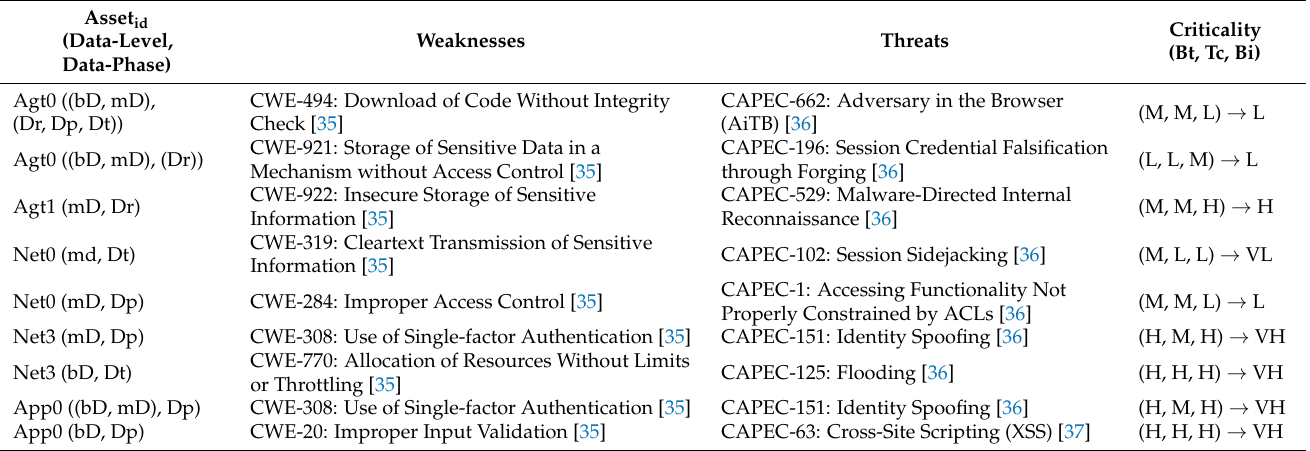
Table 7. Threat profile for Bs 0